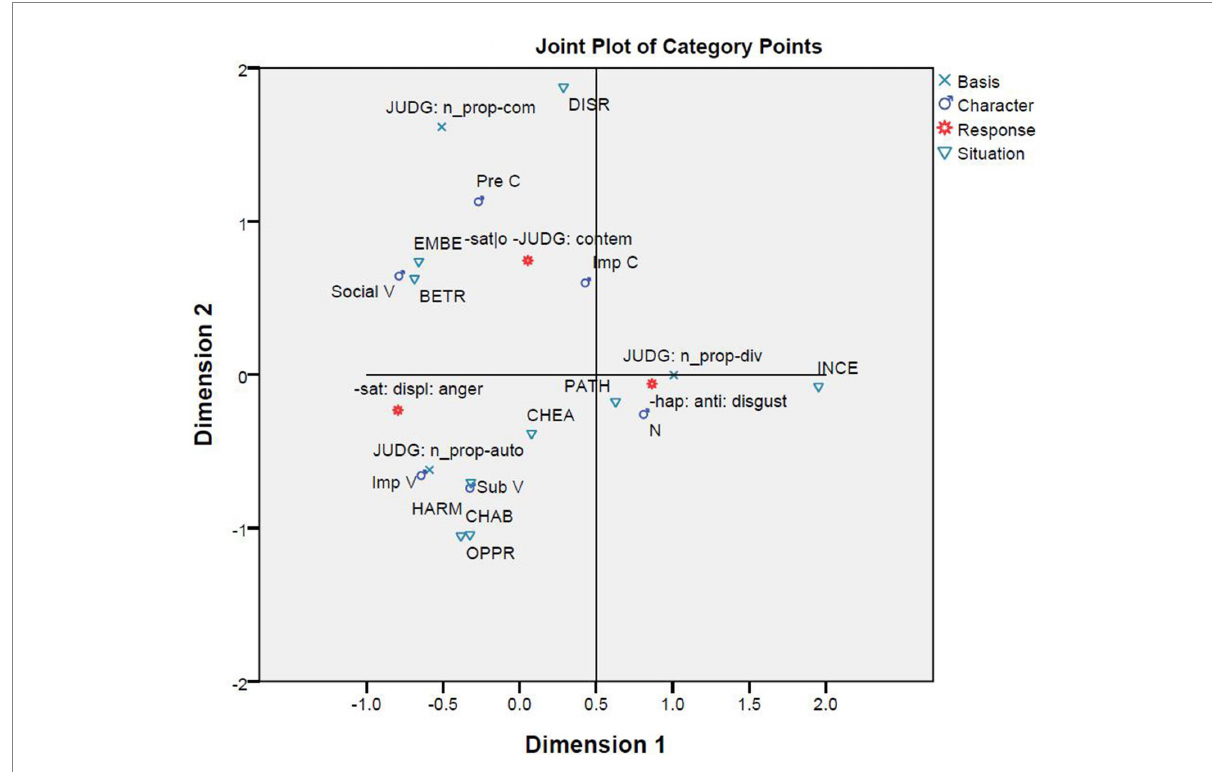
FIGURE 10 Correspondence analysis among basis, character, response, and